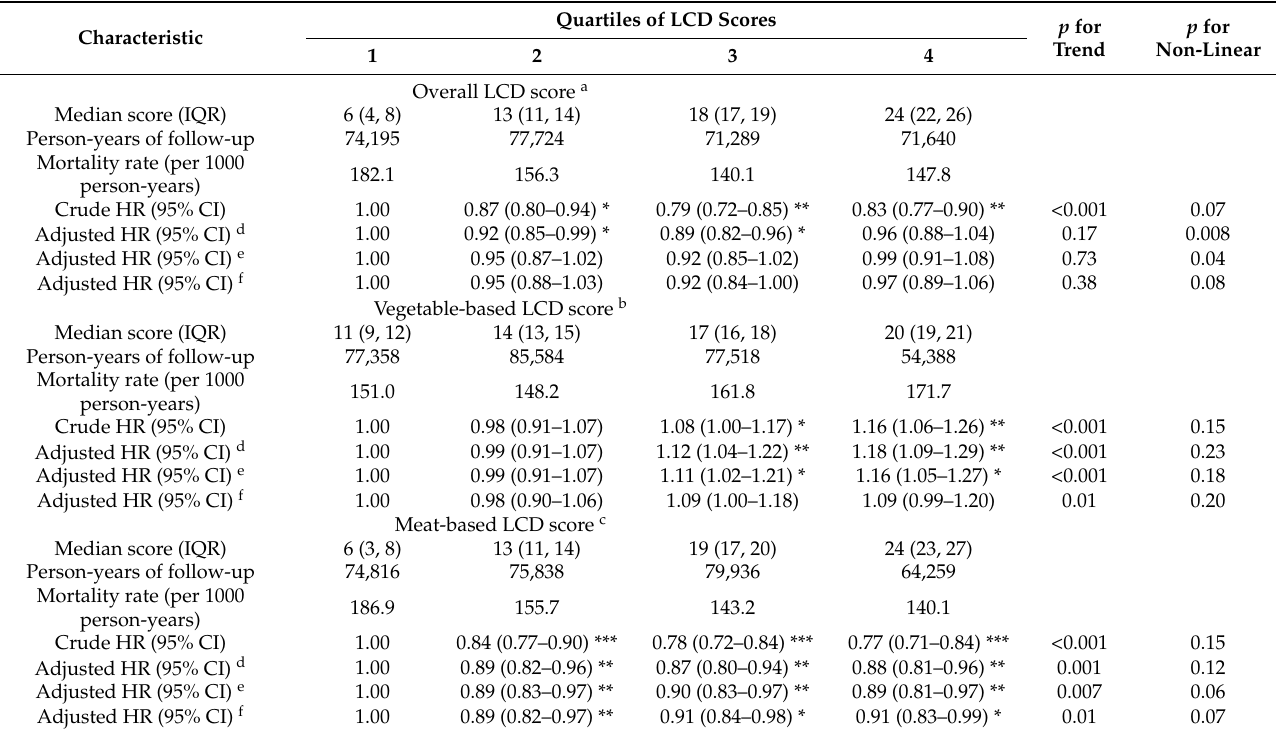
Table 2. The association of low-carbohydrate-diet (LCD) score with all-cause